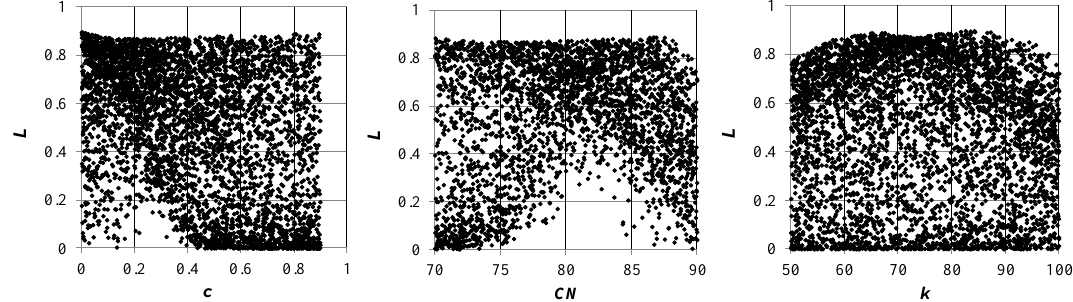
Figure 9. Scatter plots illustrating the distribution of likelihood weighted hydrological parameter values distribution.